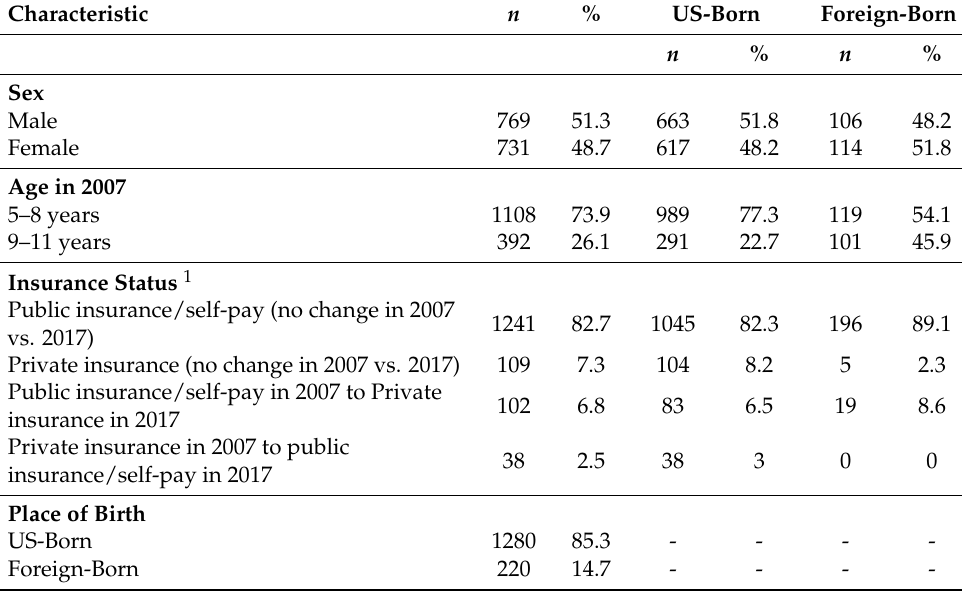
Table 1. Demographic characteristics of the study